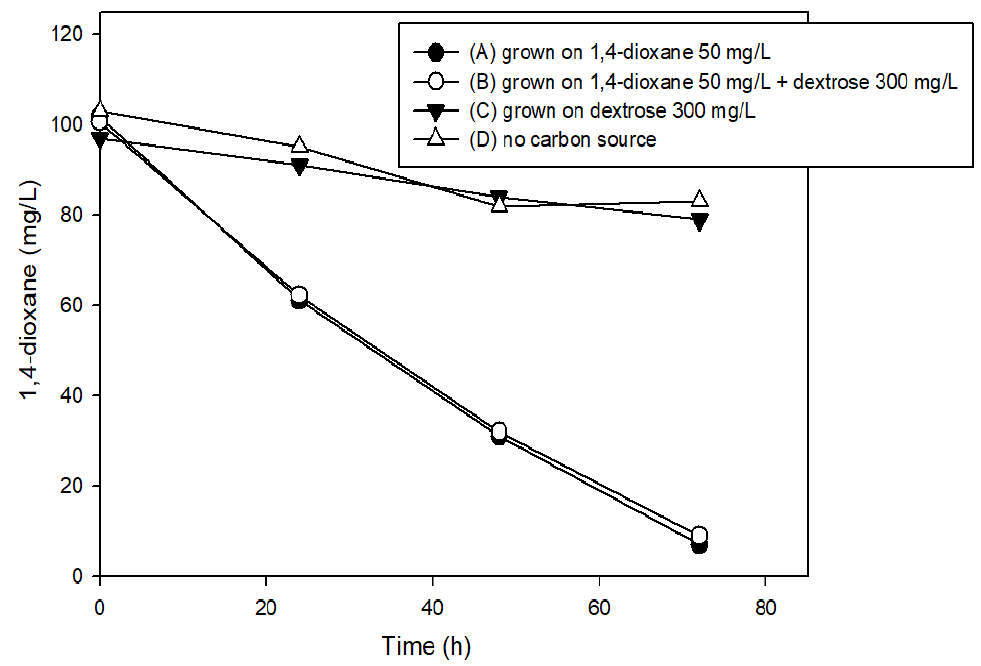
Figure 6. Biodegradation of 1,4-dioxane by cultures pre-grown with different combinations of 1,4- 1,4-dioxane and dioxane and dextrose.